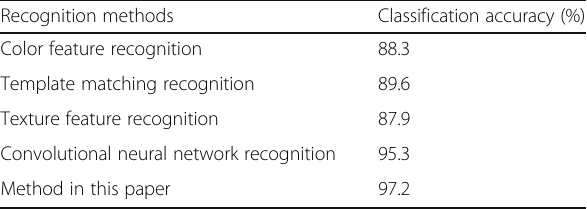
Table 3 Performance of different recognition methods Recognition